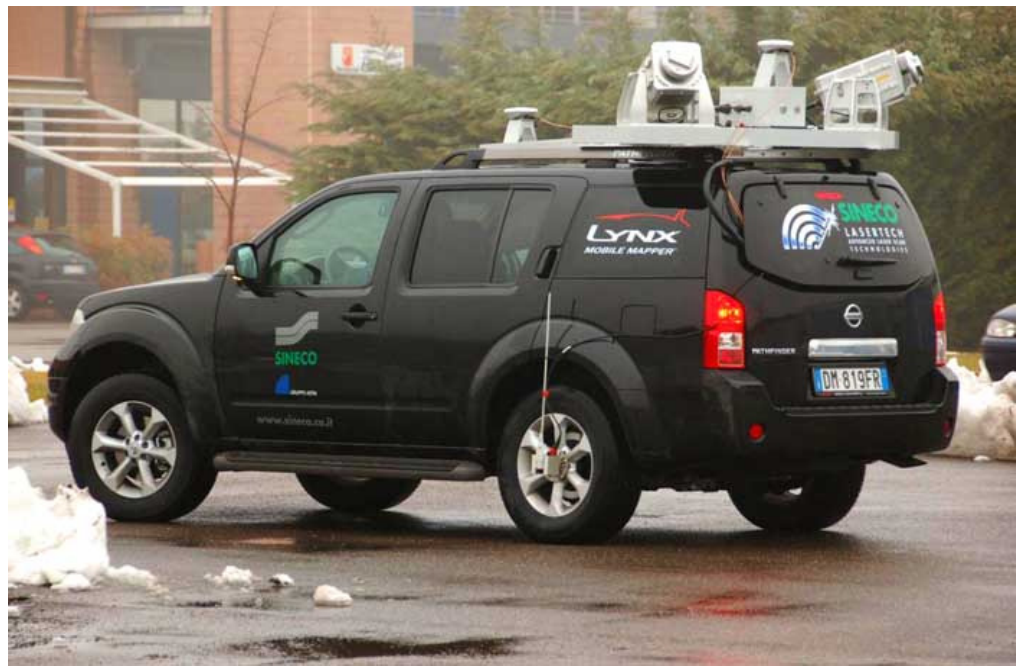
Figure 1 - Van with all the system components